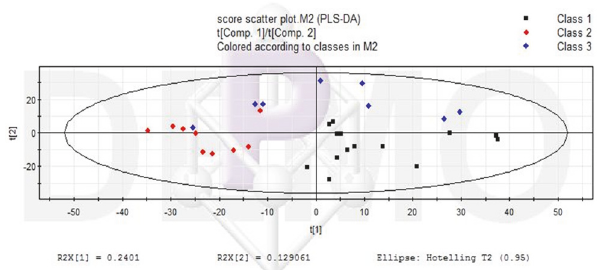
Figure 5: Scoring chart of PLS-DA pattern in treatment of chronic liver failure with nonbioartificial liver. Note the following: Class1: plasma exchange for chronic liver failure; Class2: treatment of chronic liver failure with bilirubin adsorption; Class3: hemofiltra- tion in the treatment of chronic liver